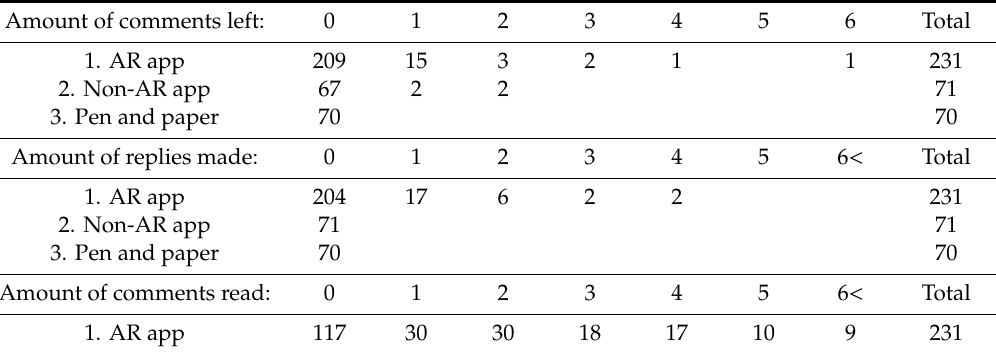
Table A1. Commenting Activity by AR Users and Non-AR Users: Frequencies of Comments Left, Replied, and Read ( N =